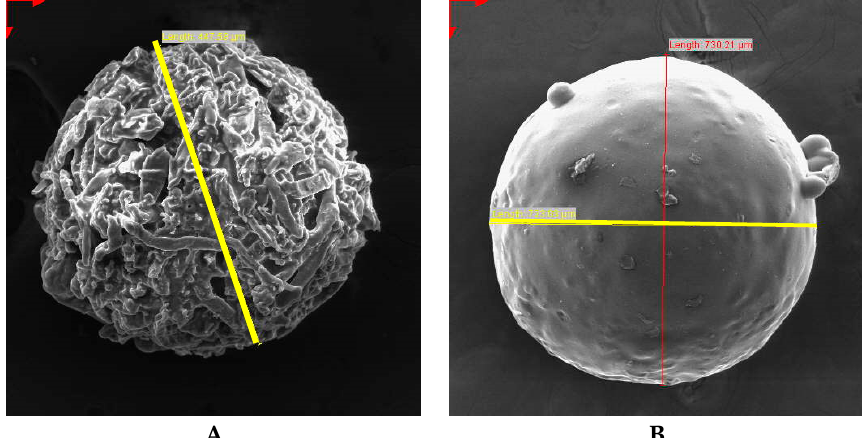
Figure 11. Scanning electron microscopy (SEM) micrographs of ( A ) optimised HCTZ (447.58 µm) and ( B ) CPT (730.21 µm) microparticles (yellow line indicates diameter).